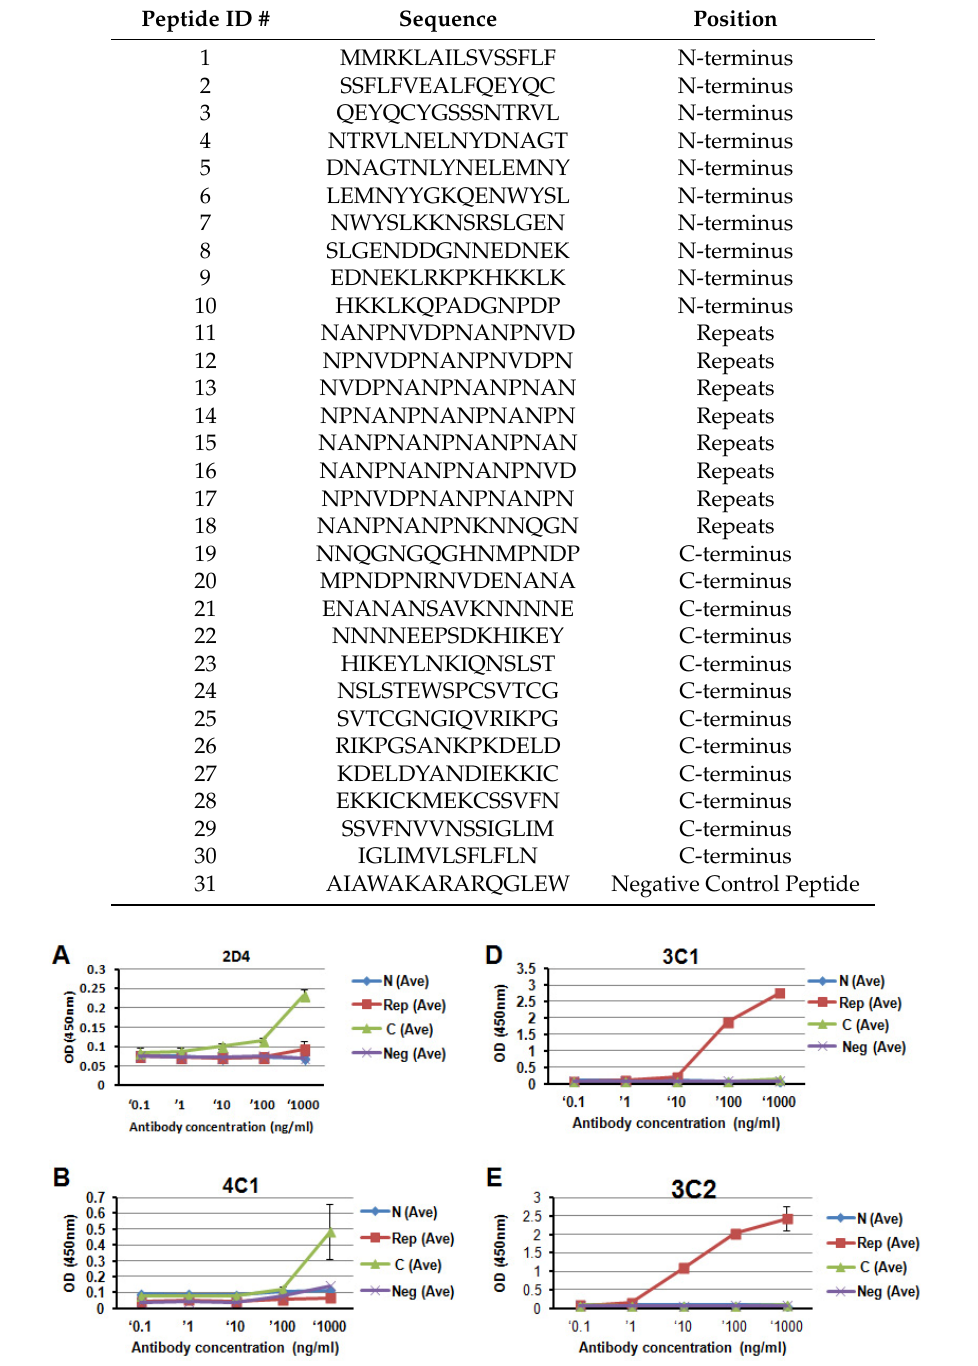
Table 2. Synthetic peptides representing PfCSP.